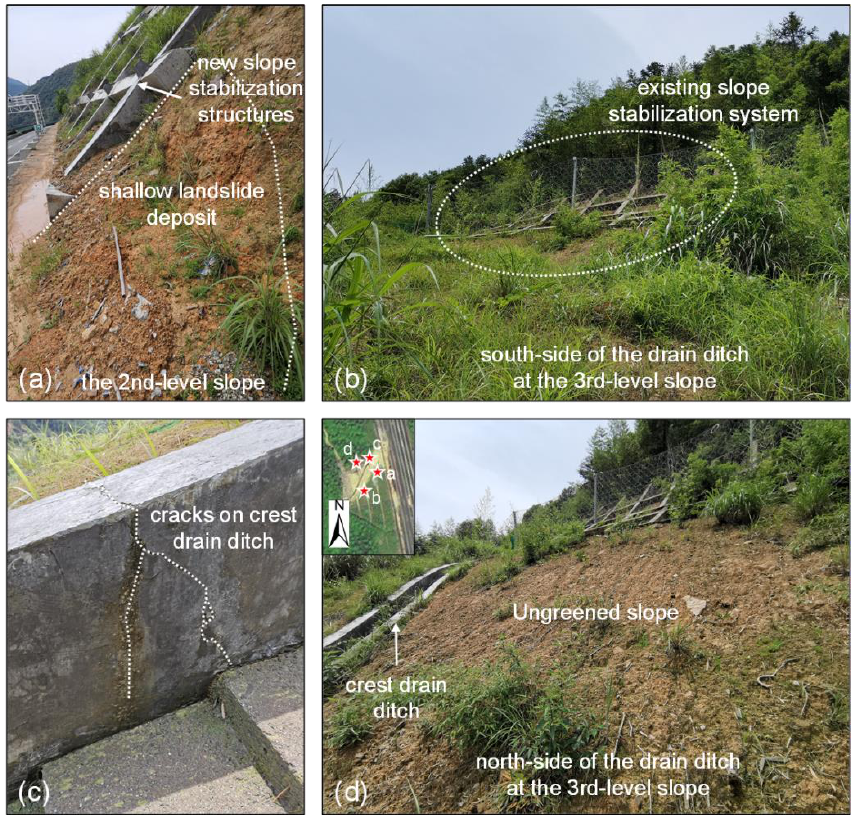
Figure 12. Field validation photographs of potential hazard P6. ( a ) Shallow landslide on top of the 2nd-level slope. ( b ) Full view on south-side of drain ditch. ( c ) Cracks on crest drain ditch. ( d ) Full view on north-side of drain ditch.